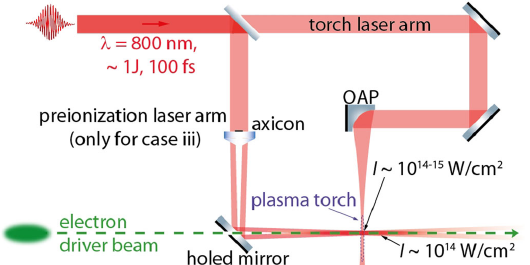
torch in perpendicular geometry approximately 1 ps before